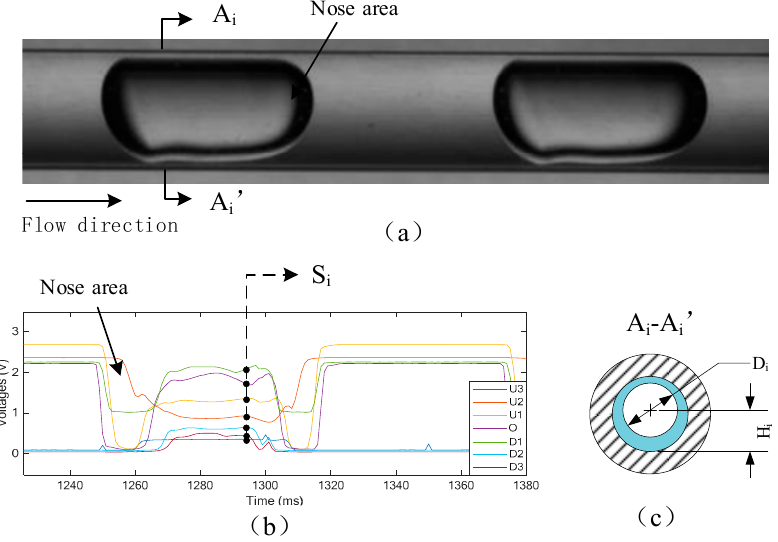
Figure 7. ( a ) Practical image of slug flow. ( b ) Optical signals. ( c ) Cross-sectional parameters.